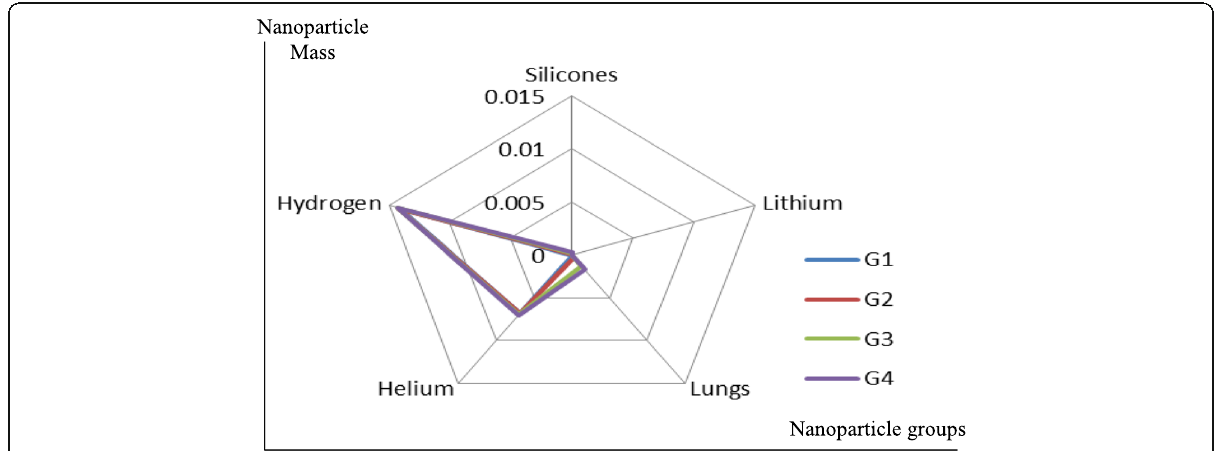
Fig. 10 Average mass of a nanoparticle in a